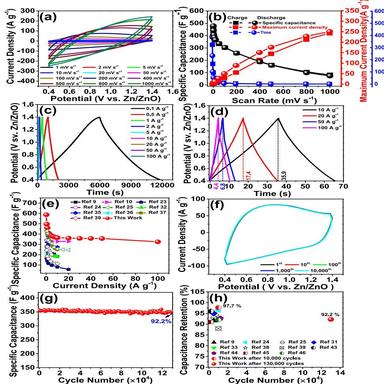
Electrochemical performance of JPC electrode in 6 M KOH electrolyte: (a) CV curves at different scan rates, (b) charge/discharge capacitance, current density Vs scan rate during CV tests, (c,d) GCD curves at different current densities, (e) Comparisons of specific capacitance of JPC electrode and the reported biomass carbon materials at different current densities, (f) CV cycling assessment at scan rate of 200 mV s1 for 10,000 cycles, (g) GCD cycling test at high current density of 50 A g-1over 130,000 cycl